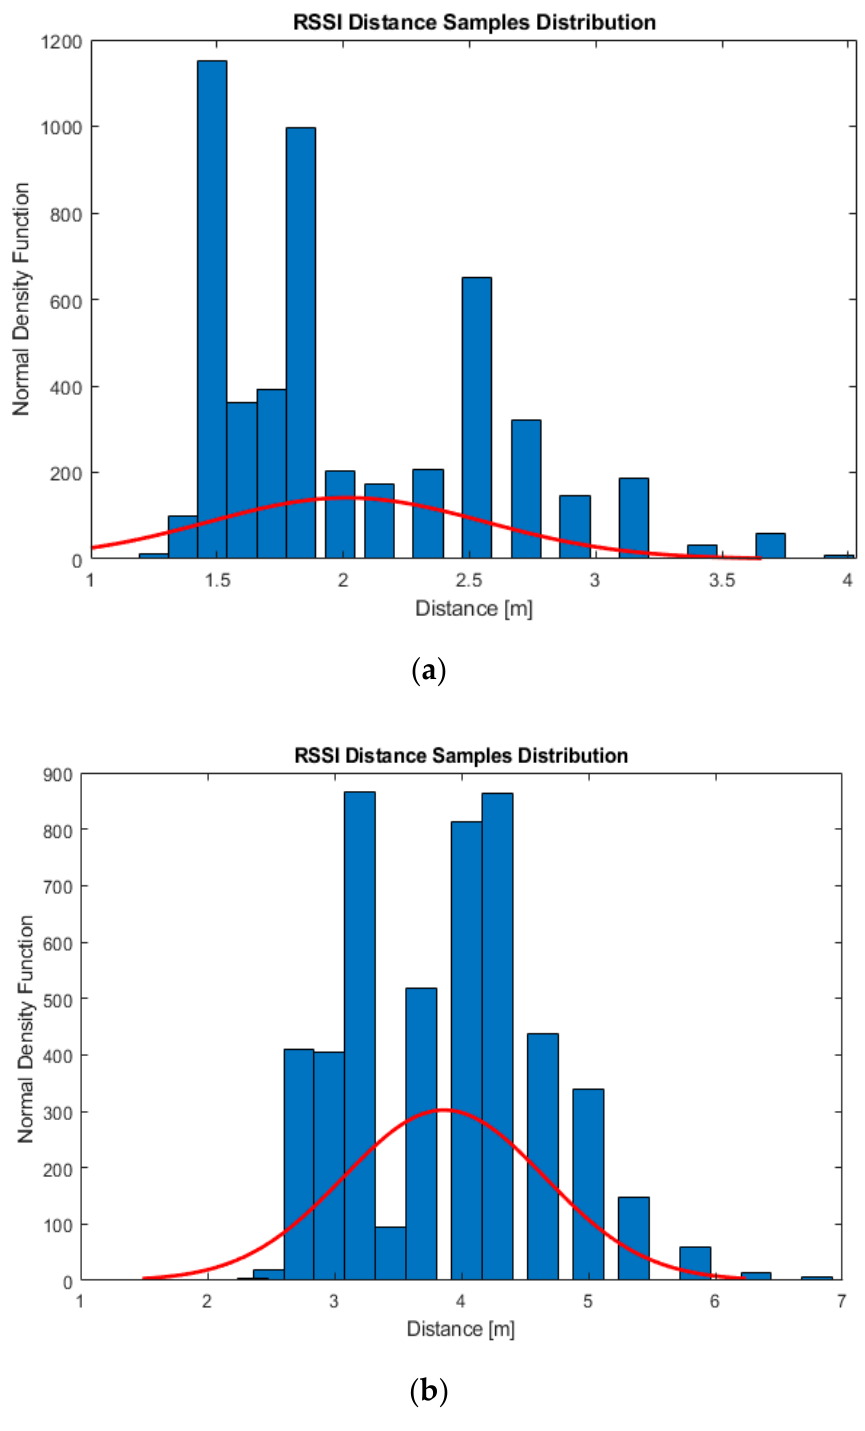
Figure 1. The distribution of RSSI distance samples fitted to the normal density function at: ( a ) 1 m where ( D mean > D median ); ( b ) 2 m where ( D mean < D median ) .